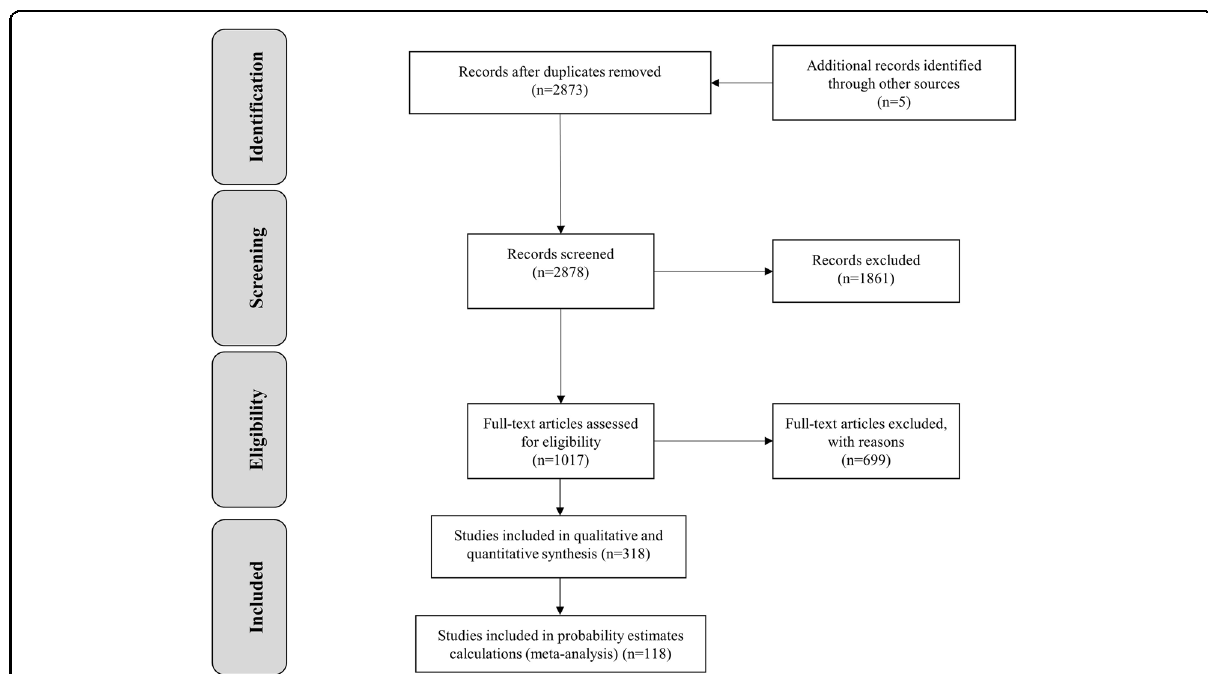
Fig. 1 PRISMA fl ow diagram of the studies included in the analyses. n = number of